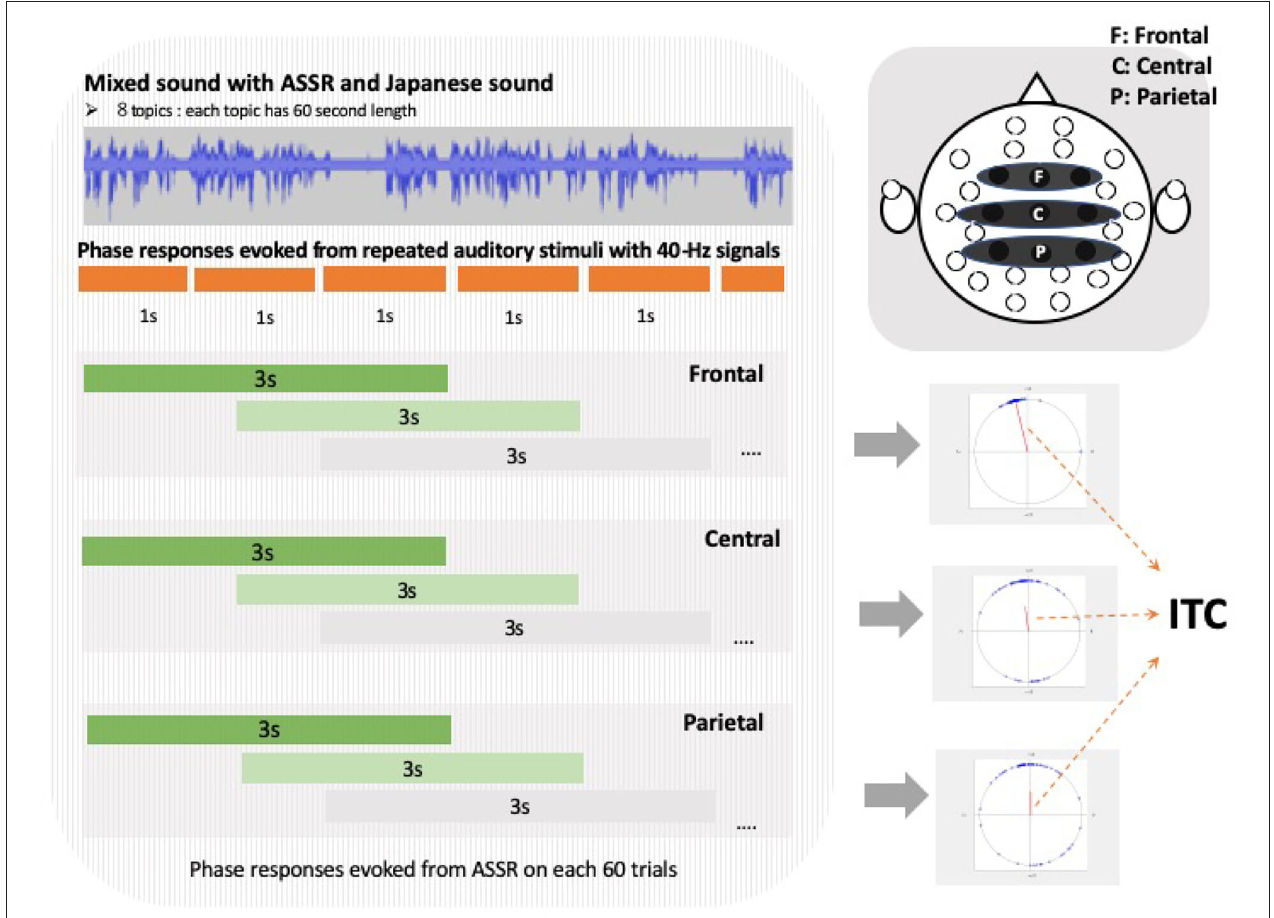
FIGURE 3 | Left figure shows inter-trial coherence (ITC) calculation method of each regions of interest (ROI). Each red line in center of three circles in lower right diagram is direction and magnitude of average composite vector as ITC, and blue dots at edges of circle indicate phases in each